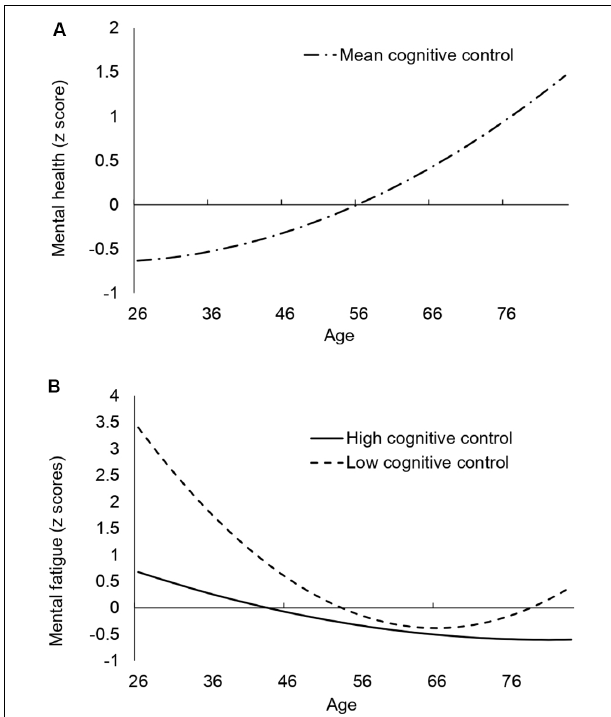
FIGURE 1 | (A) Estimation of the growth curve of mental health. The line represents the mental health score when entering the mean cognitive control score. (B) Estimation of the growth curve of mental fatigue. The solid line represents higher cognitive control abilities at Wave 1; and the dashed line represents lower cognitive control abilities at Wave 1 ( ± 1 SD than the mean, respectively).